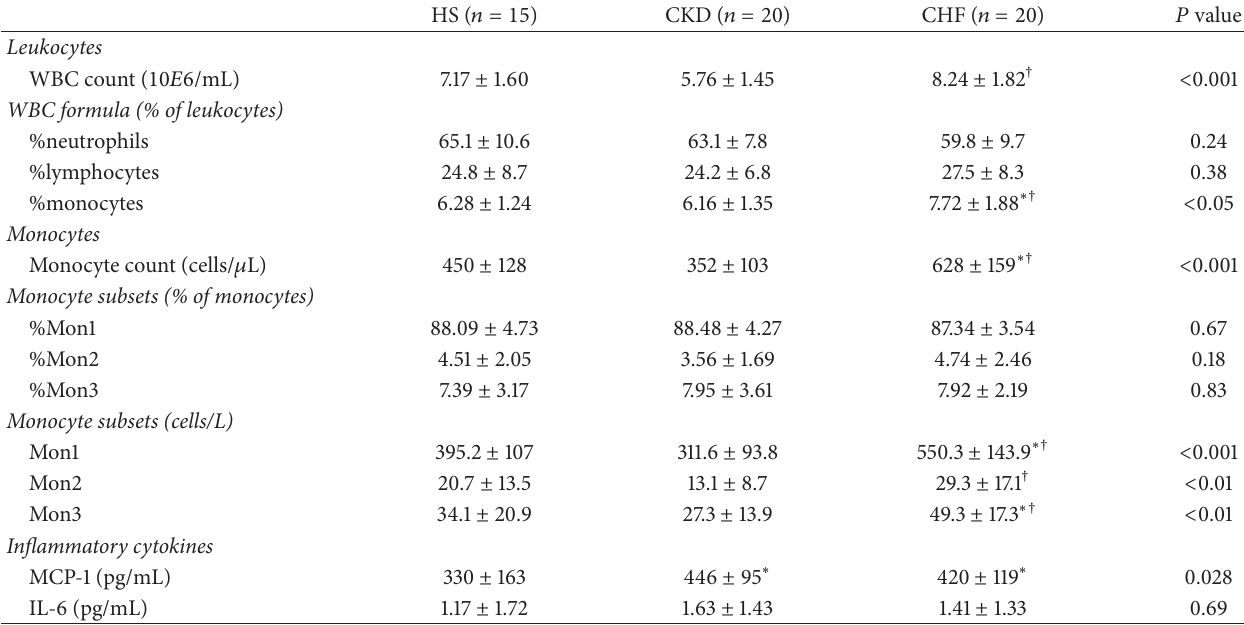
Table 2: Distribution of monocyte subsets and levels of inflammatory proteins at baseline.